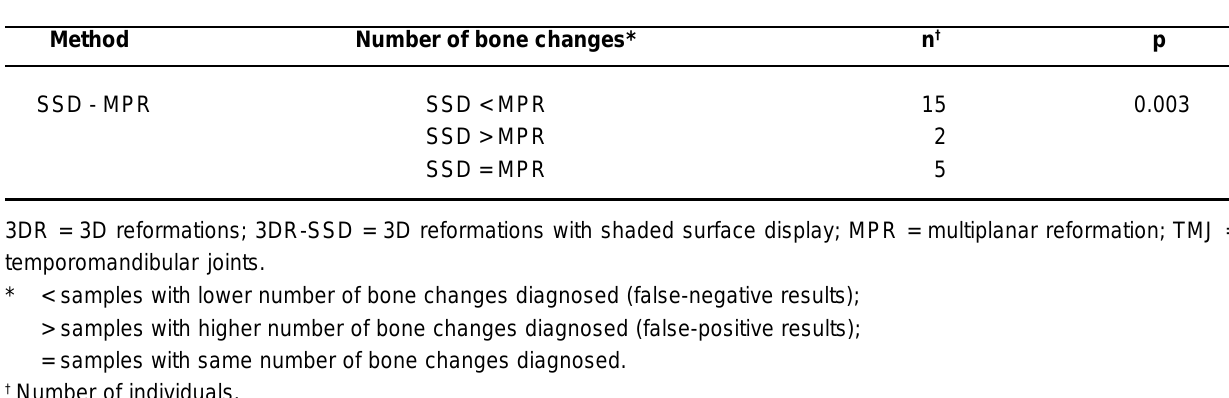
TABLE 1 - Relationship between the number of bone changes diagnosed with MPR and with 3DR-SSD, considering each patient individually (n=22)